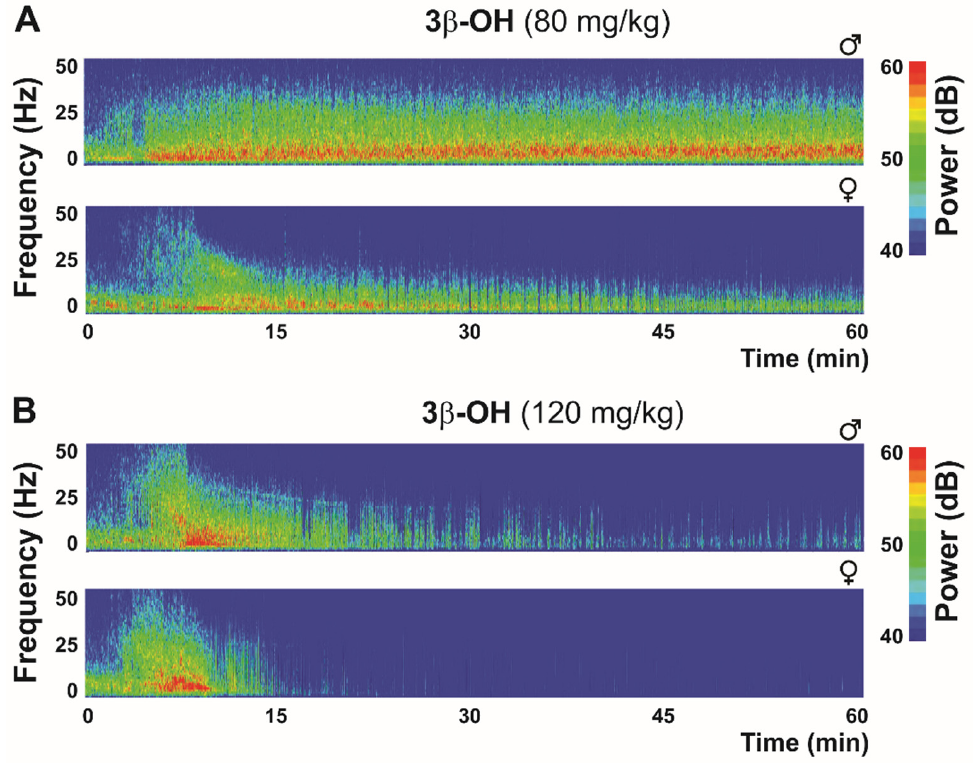
Figure 3. Thalamic (central medial nucleus of thalamus—CeM) heat maps after hypnotic (80 mg/kg ( A )) and anesthetic (120 mg/kg ( B )) dose of neuroactive steroid 3 β -OH in WT mice.